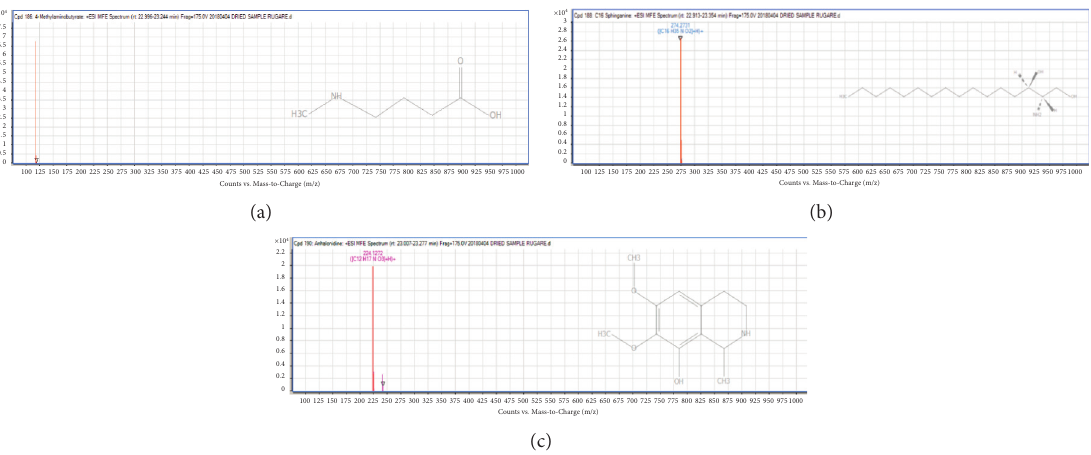
Figure 3: Cumulative LC-MS spectra for (a) 4-methylaminobutyrate, (b) C16 sphinganine, and (c) oleamide that were detected in sorghum variety SC Macia extracts. Table 5: Retention times, mass spectra data, and tentative identification of the phenolic compounds in sorghum variety SC Macia. Proposed compound Chemical formula Rt (min) Exact mass Calculated mass Volume (%) Score